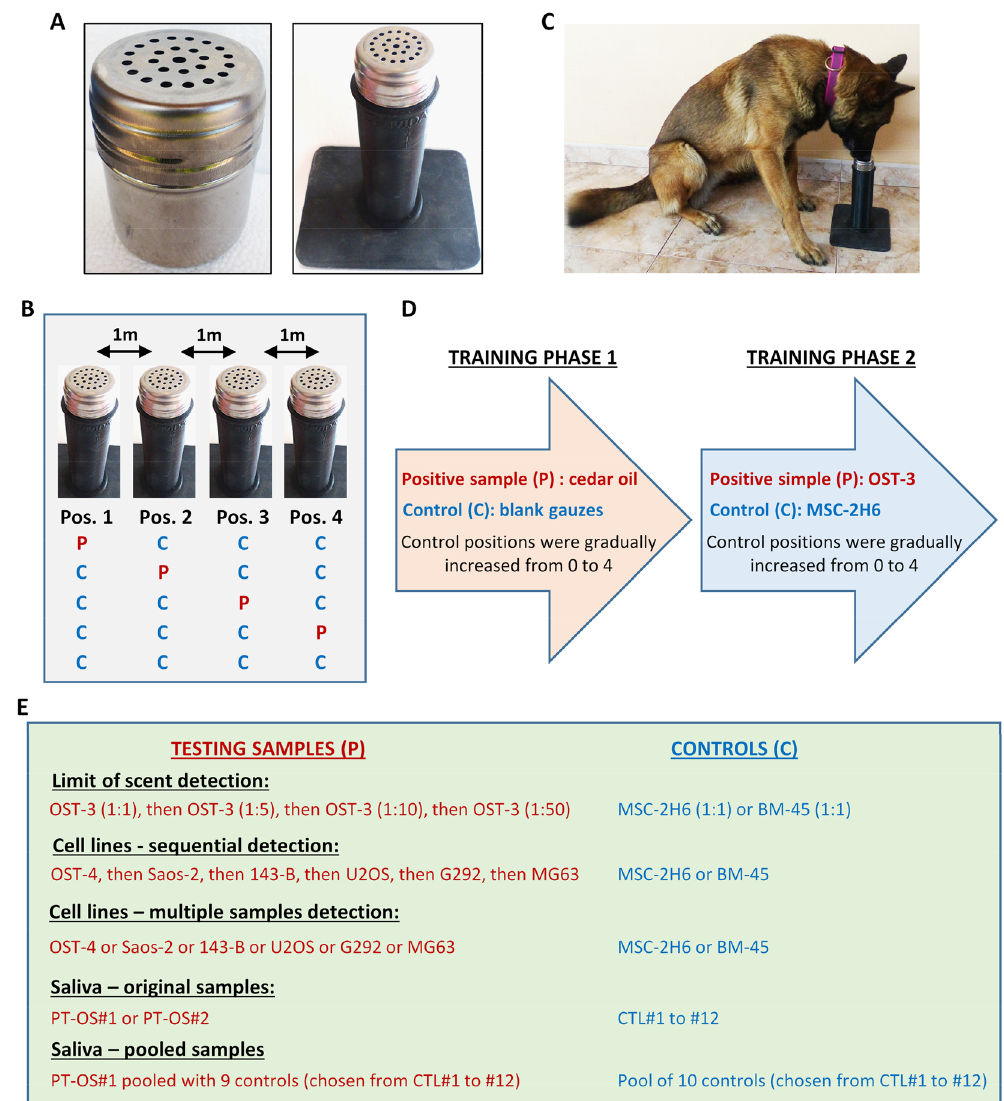
Figure 1. Experimental design and samples used in training and testing experiments. ( A ) Samples were placed in containers with perforated lids (left) which were in turn inserted into cylindrical buckets (right). ( B ) Four sample containers were arranged in a row at 1-m intervals. The dogs were off-leash during the searching experiments and they sniff the positions in sequential order from position 1 to 4. Possible combinations of positive samples and controls are shown. Samples used in each trial, as well as their position, were randomly selected by the assistant. ( C ) Dogs were trained for a “sit stare” final response when finding a target sample. ( D ) Scheme showing the phases of the training and the samples used in each one. ( E ) Positive and control samples used in the different testing